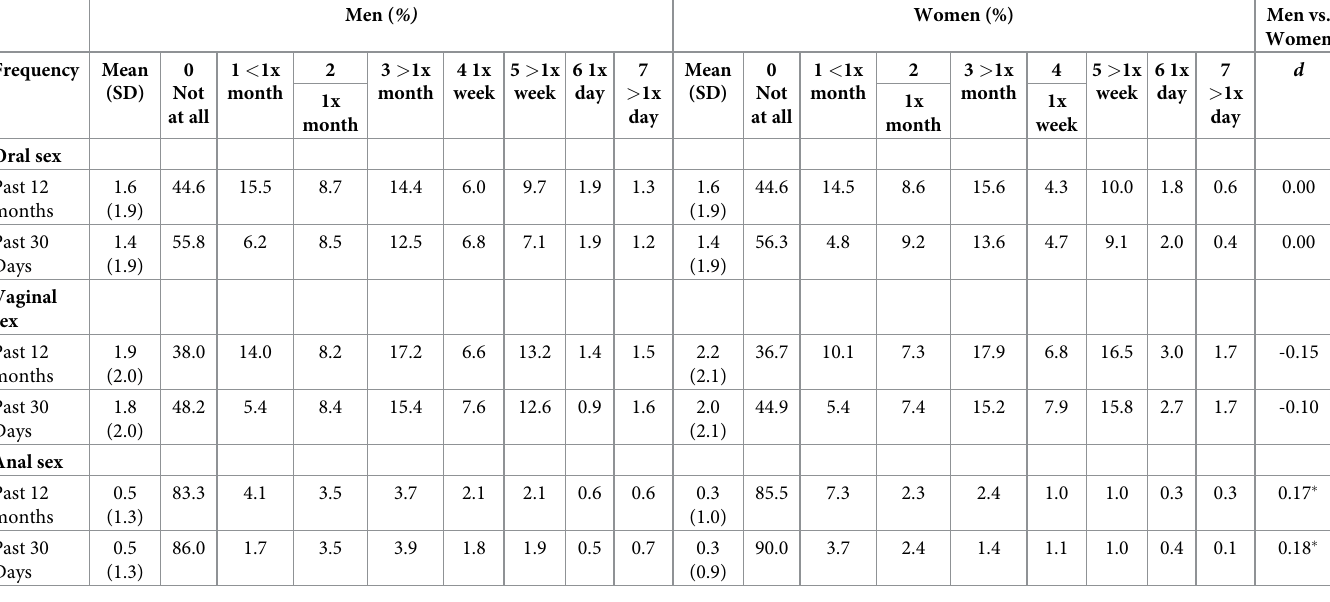
Table 3. Frequency of oral, vaginal, and anal sex in the past 12 months and past 30 days ( N = 1,987; men n = 953, women n = 1015).